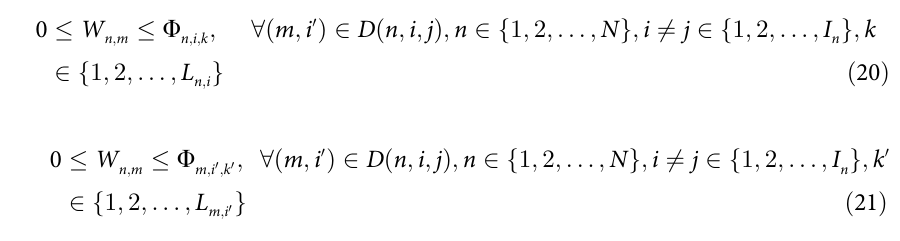
for a selected path h o ; d ; h o ; d